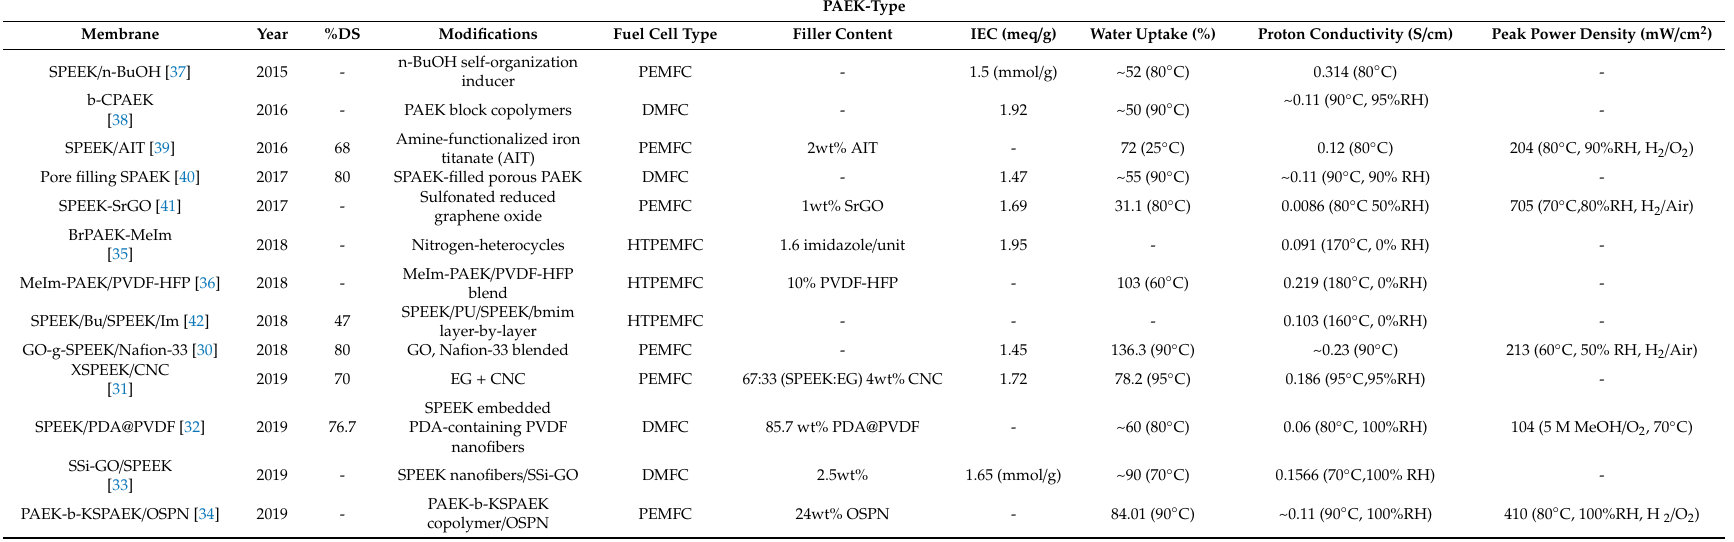
Table 3. Water uptake and electrochemical properties of PAEK-type